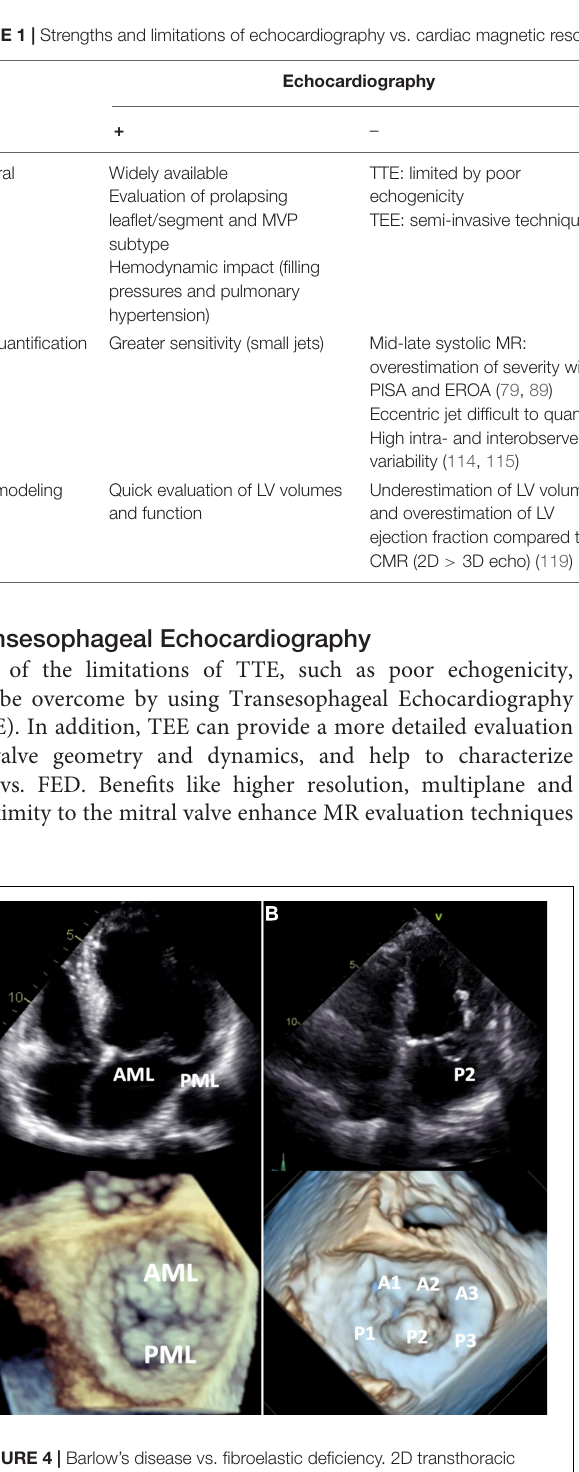
FIGURE 4 | Barlow’s disease vs. fibroelastic deficiency. 2D transthoracic four-chamber view (upper panels) and 3D transesophageal focused view of the mitral valve (lower panels). (A) Barlow’s disease with annular dilatation, thickened leaflets and bileaflet prolapse (anterior + posterior mitral leaflet). (B) Fibro-elastic deficiency with prolapse (flail) of the P2 segment of the posterior mitral leaflet due to chordal rupture. Mitral annulus diameter is normal in this case, but mild annular dilatation can be present. AML, anterior mitral leaflet; PML, posterior mitral